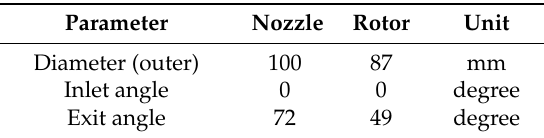
Table 3. Initial design parameters of the turbine.